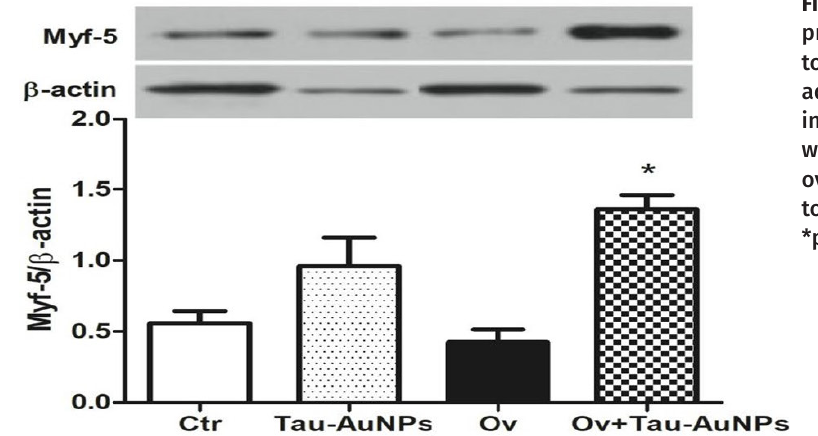
Figure 4. Muscle differentiation protein (Myf-5) of mice subjected to overuse exercise and Tau-AuNPs administration. The myf-5 level was increased in the Ov+Tau-AuNPS when compared to control and overuse animals. *p≤0.05 compared to the control and Tau-AuNPs. *p≤0.05 compared to the